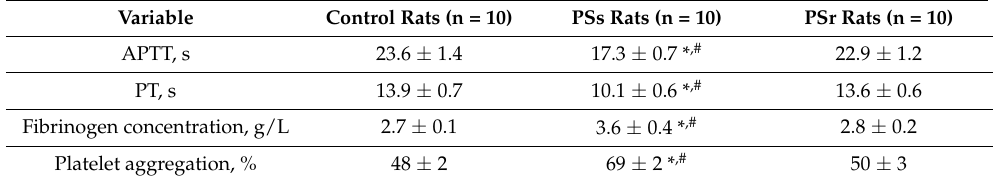
Table 3. Data from blood coagulation